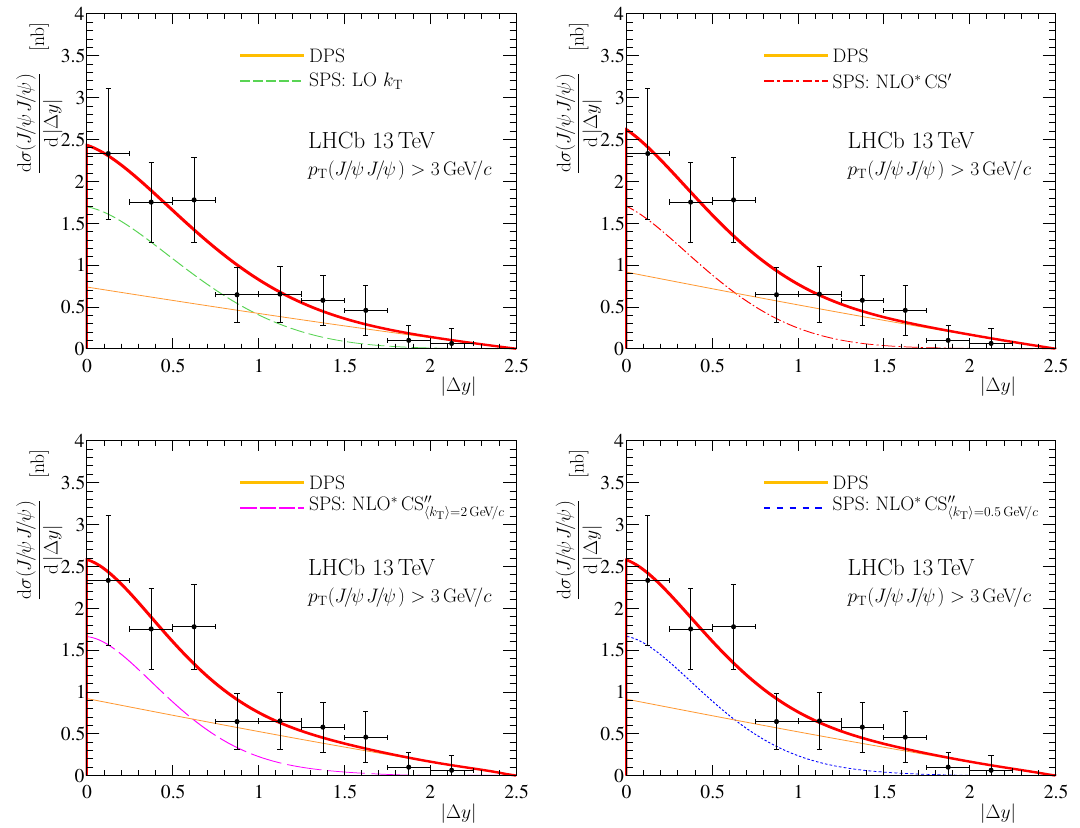
Figure 15. Result of templated DPS (cid:12)t for d (cid:27) ( J= J= ) for the p T ( J= J= ) > 3 GeV =c region. The d j (cid:1) y j (black) points with error bars represent the data. The total (cid:12)t result is shown with the thick (red) solid line and the DPS component is shown with the thin (orange) solid